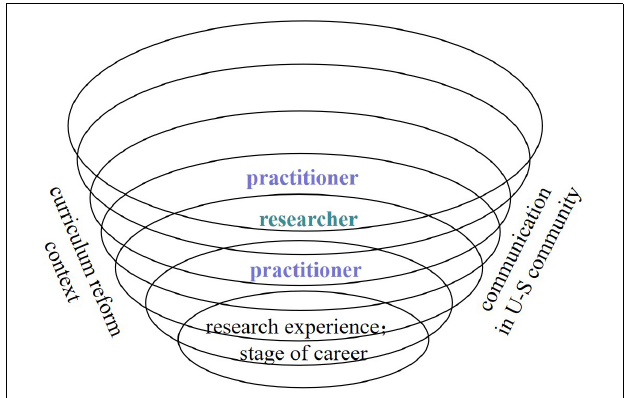
FIGURE 2 | School teachers’ research identity transformation and its influencing